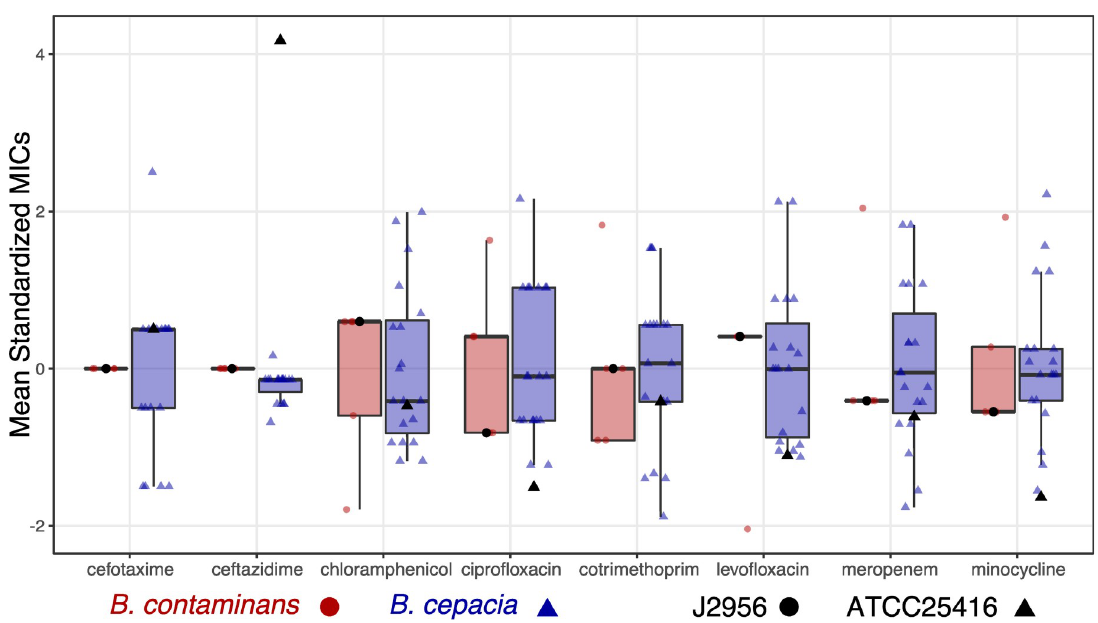
Fig 9. Antibiotic screening. Each individual data point plotted represents the mean of 3 replicates. Boxplots of those means standardized within that antibiotic and species are plotted for each antibiotic for both species (red and circles = B . contaminans ; blue and triangles = B . cepacia ). And black versions of the shapes are where the associated reference strains fall on that